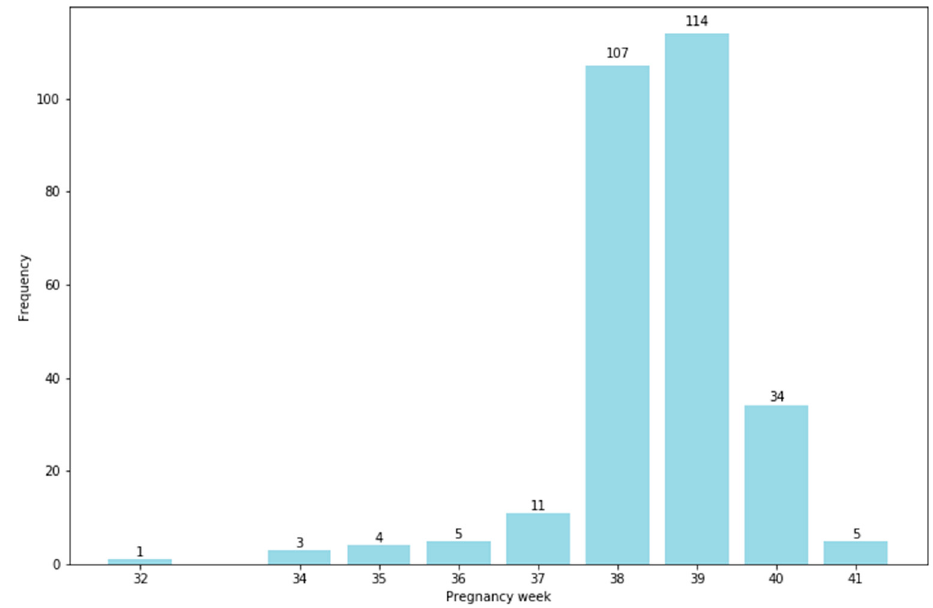
Figure 1. Gestational week at the time of delivery.